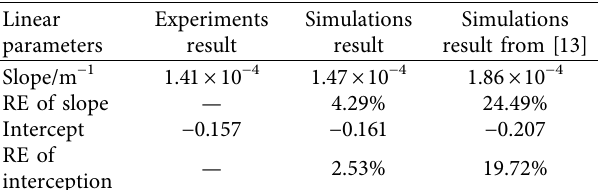
Table 7: Comparison of linear fitting curves for simulation results and test data.